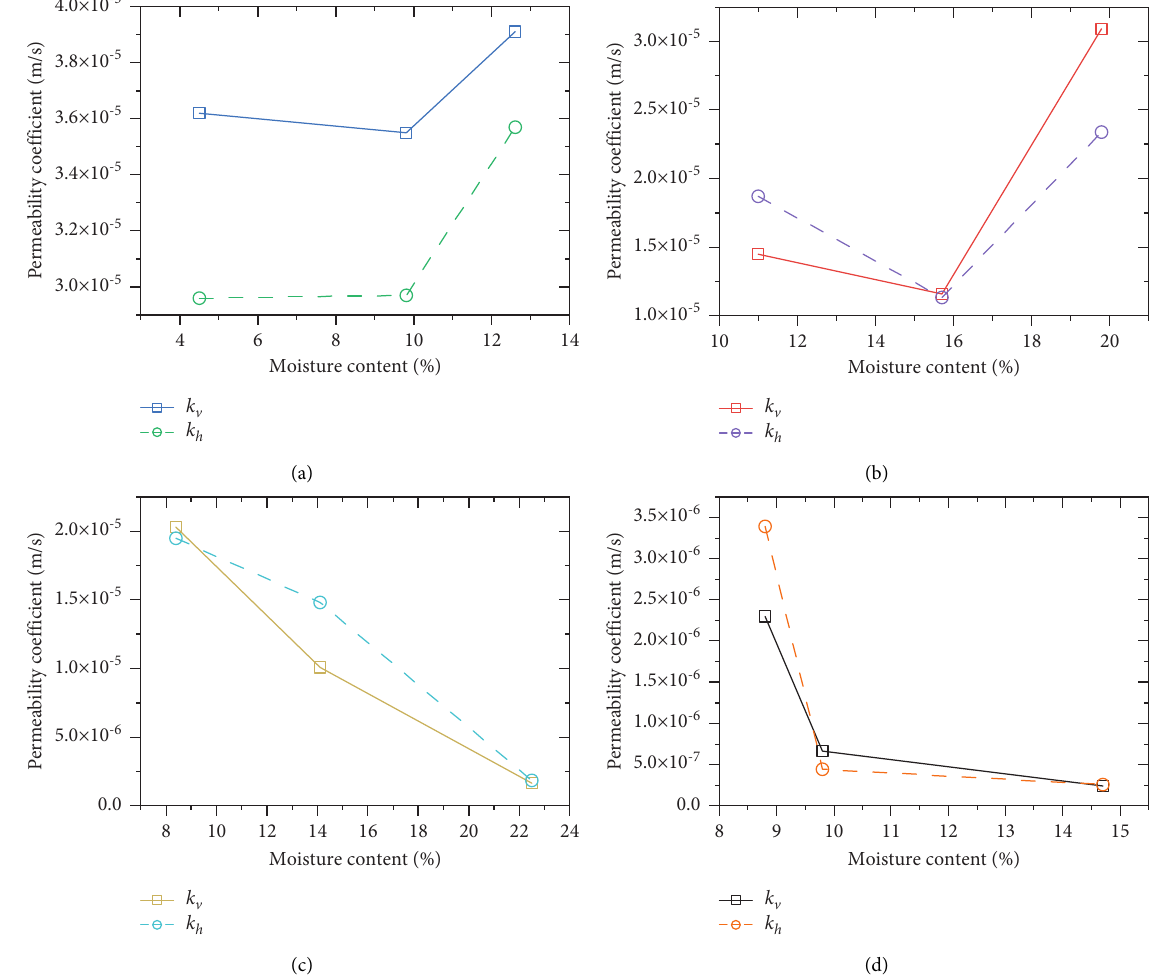
Figure 7: Relation curve between permeability coefficient and water content of undisturbed loess. (a) Group IA. (b) Group IB. (c) Group IC. (d) Group